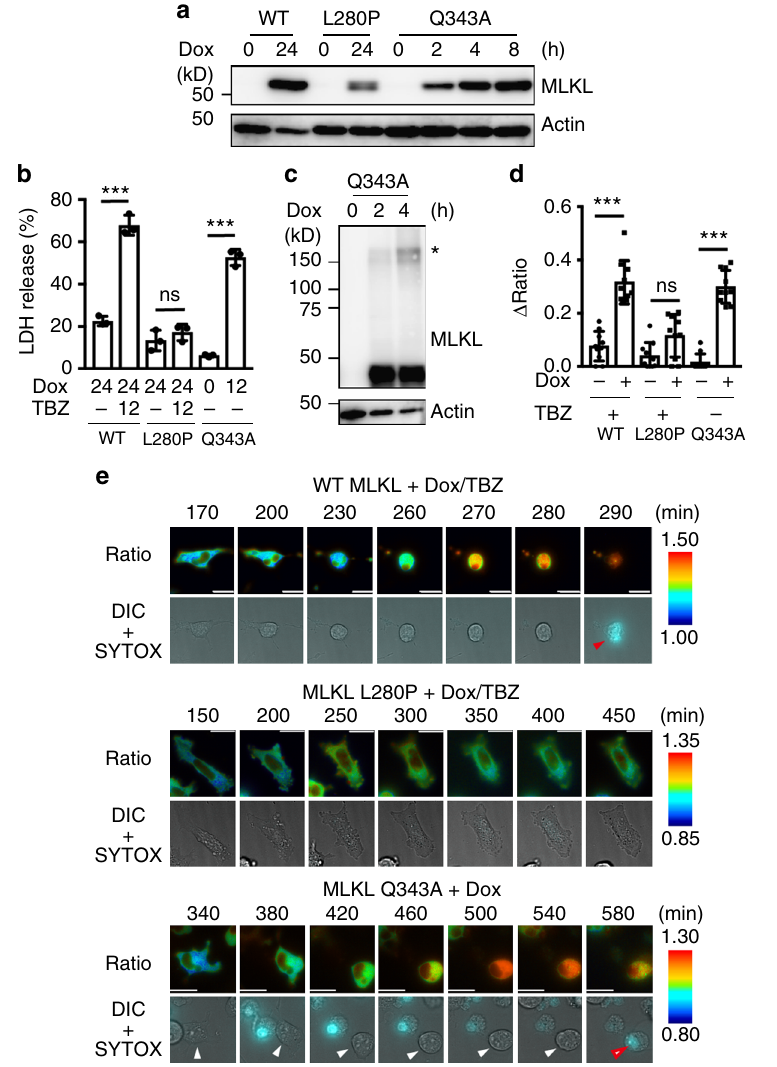
Fig. 5 SMART monitors oligomerization of MLKL. a Mlkl − / − MEFs-SMART were transfected with Dox-inducible lentiviral vectors for WT MLKL, MLKL L280P, or MLKL Q343A. Cells were treated with Dox for the indicated times. Expression of MLKL mutants was analyzed by immunoblotting with the anti- MLKL antibody. b Mlkl − / − MEFs-SMART/WT MLKL and MLKL L280P were treated with Dox as in ( a ) and then untreated or further stimulated with